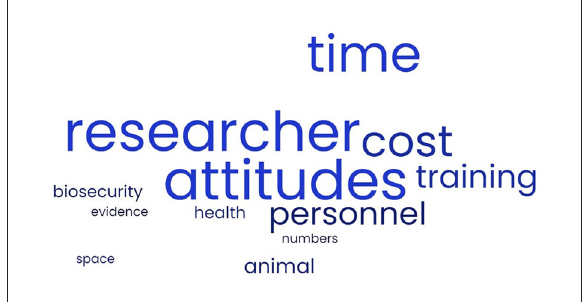
FIGURE1 Word Cloud of the most significant day-to-day concerns of laboratory animal professionals working with research rats and/or mice.